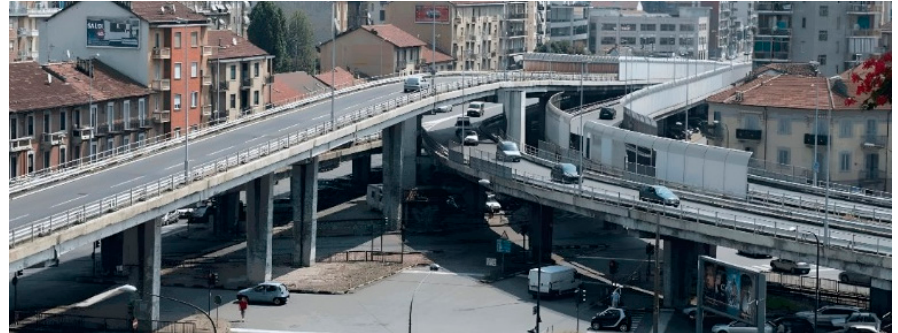
Figure 1. Historical view of the Corso Grosseto viaduct. The deck of each span consisted of 10 precast PC I-beams and 2 U beams all connected by a cast in situ slab, with transverse beams at third points of each span. Figure 2 shows a technical drawing of the top view and cross-section of the viaduct. The elements retrieved for the project are depicted in Figure 2a in green, whereas the elements tested, whose results are reported in this paper, are painted in red.